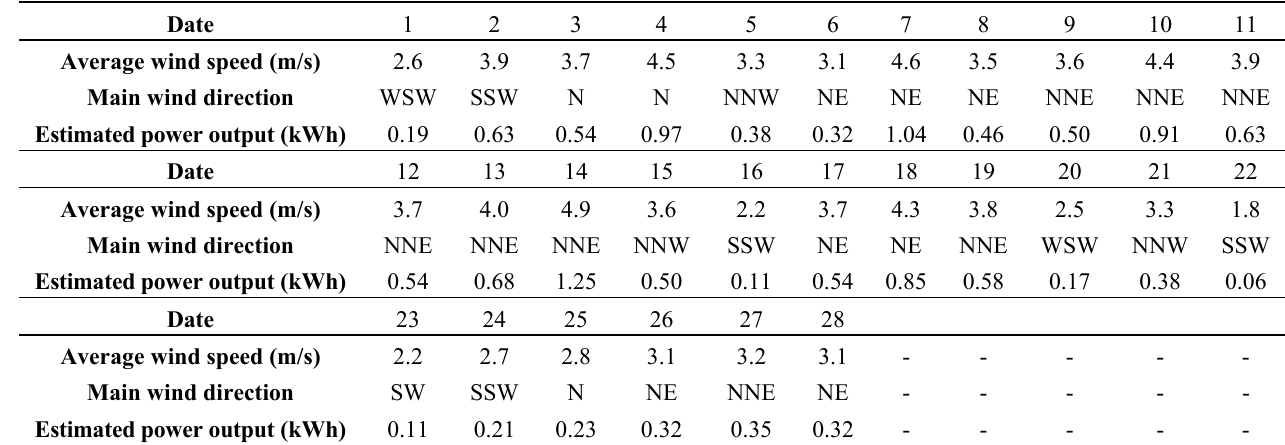
Table A2. Estimated power output per day in February.